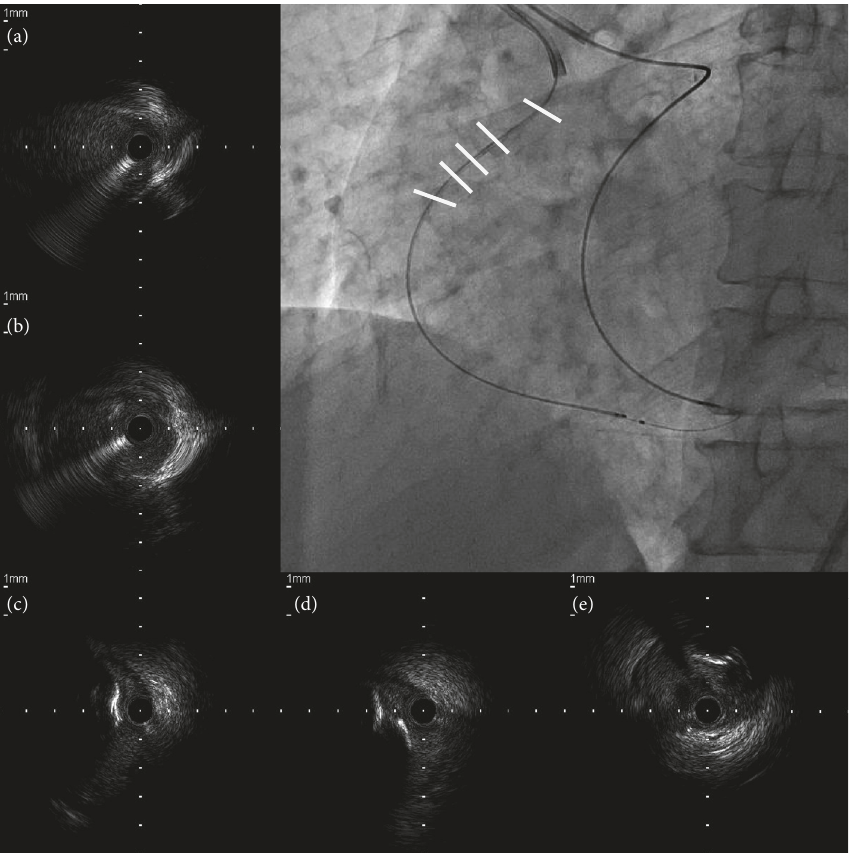
Figure 5: Intravascular ultrasound (IVUS) examination. IVUS was performed after guidewire externalization. Serial IVUS images of right coronary artery (RCA) show the ostial RCA (a), the guidewire entering into the true lumen from the false lumen at the proximal RCA (b), and the guidewire passing the chronic total occlusion (CTO) segment through the subintimal space, avoiding the severely calcified plaque at the proximal segment of CTO ((c)–(e)). Images are viewed in a proximal (a) to distal (e) direction.